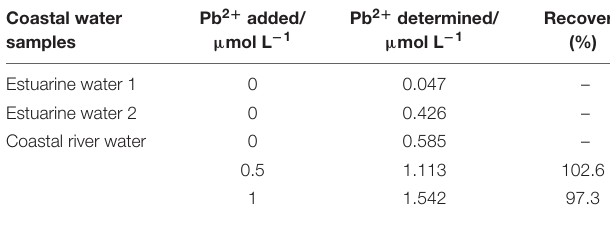
TABLE 2 | Results of Pb 2 + determination in real coastal water samples ( n = 3) obtained with the 3DrGO/F-BiNSs/ANE.